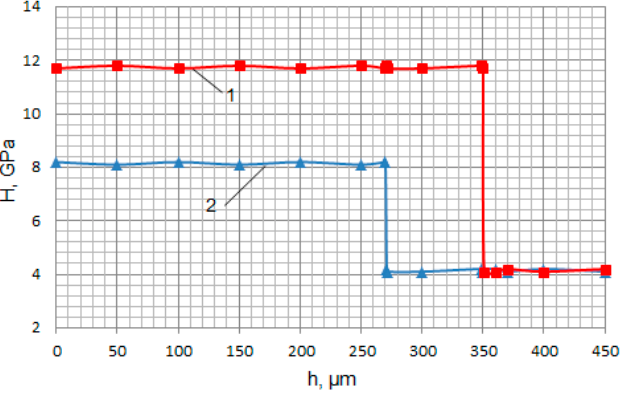
Figure 6. Change in microhardness according to the thickness of the chromium electrochemical coating formed in the electrolyte: 1—flow; 2—calm.